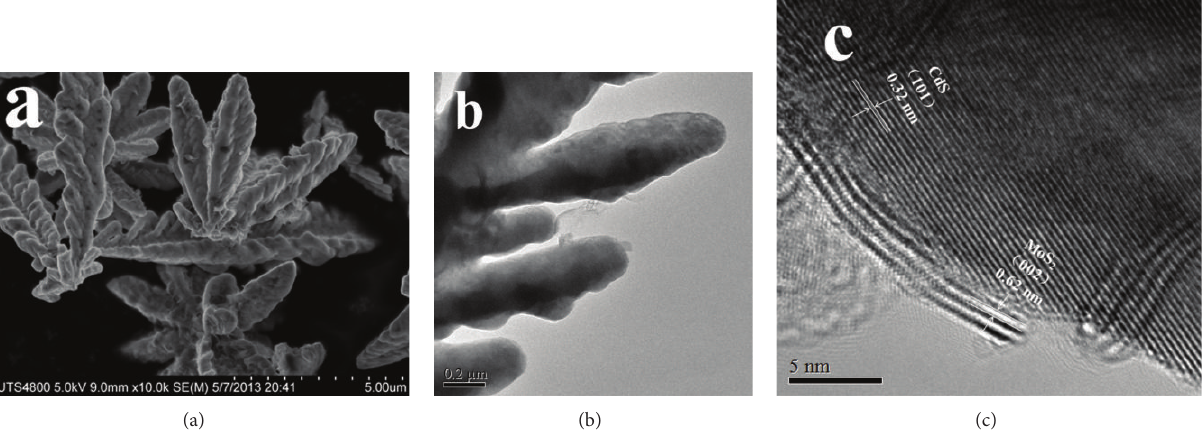
Figure 1: SEM and TEM images of MoS 2 /CdS samples.